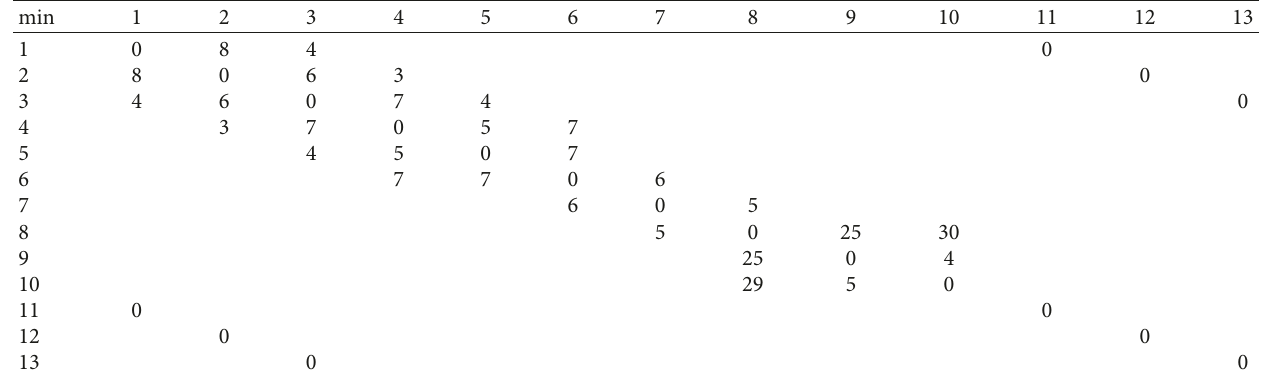
Table 13: The routing time between locations of Group